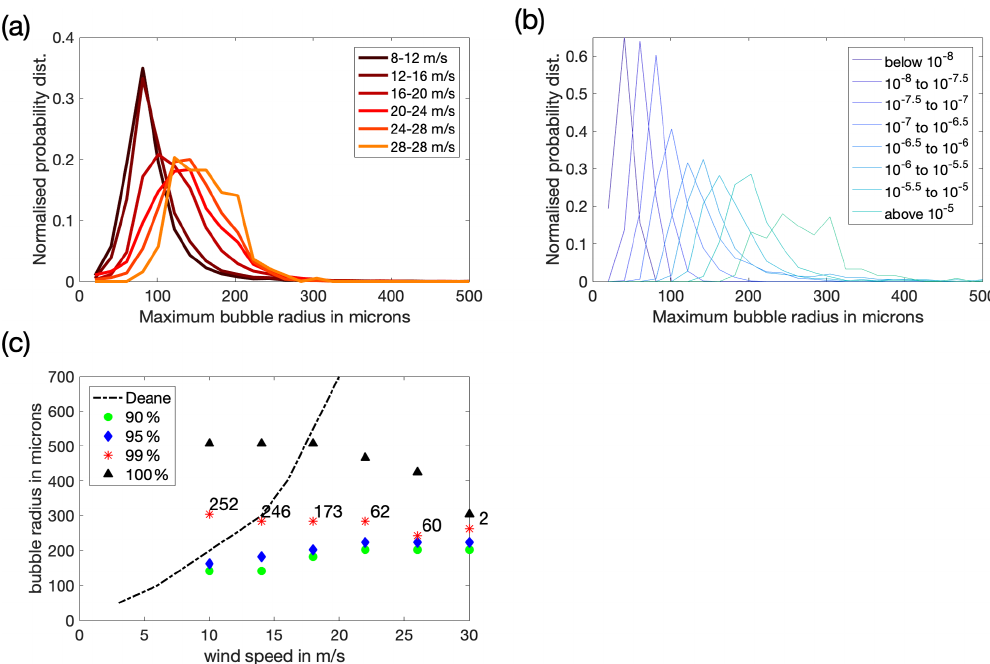
Figure 1. (a) Probability density functions of the maximum bubble radius in each 1s distribution at 2m depth, segregated by wind speed. (b) Normalised probability distributions of the maximum bubble radius seen in each 1s distribution at 2m depth, segregated by void fraction. Note that there are only 123 1s measurements where the void fraction seen was above 10 − 5 . (c) The 90th , 95th, 99th and 100th percentiles of the probability distribution of maximum bubble sizes in each wind speed bin. The dashed line shows the escape radius prediction of Deane et al. (2013) at 2m depth. The number of photographs making up 1% of the distribution at each wind speed range is labelled next to the 99th percentile data